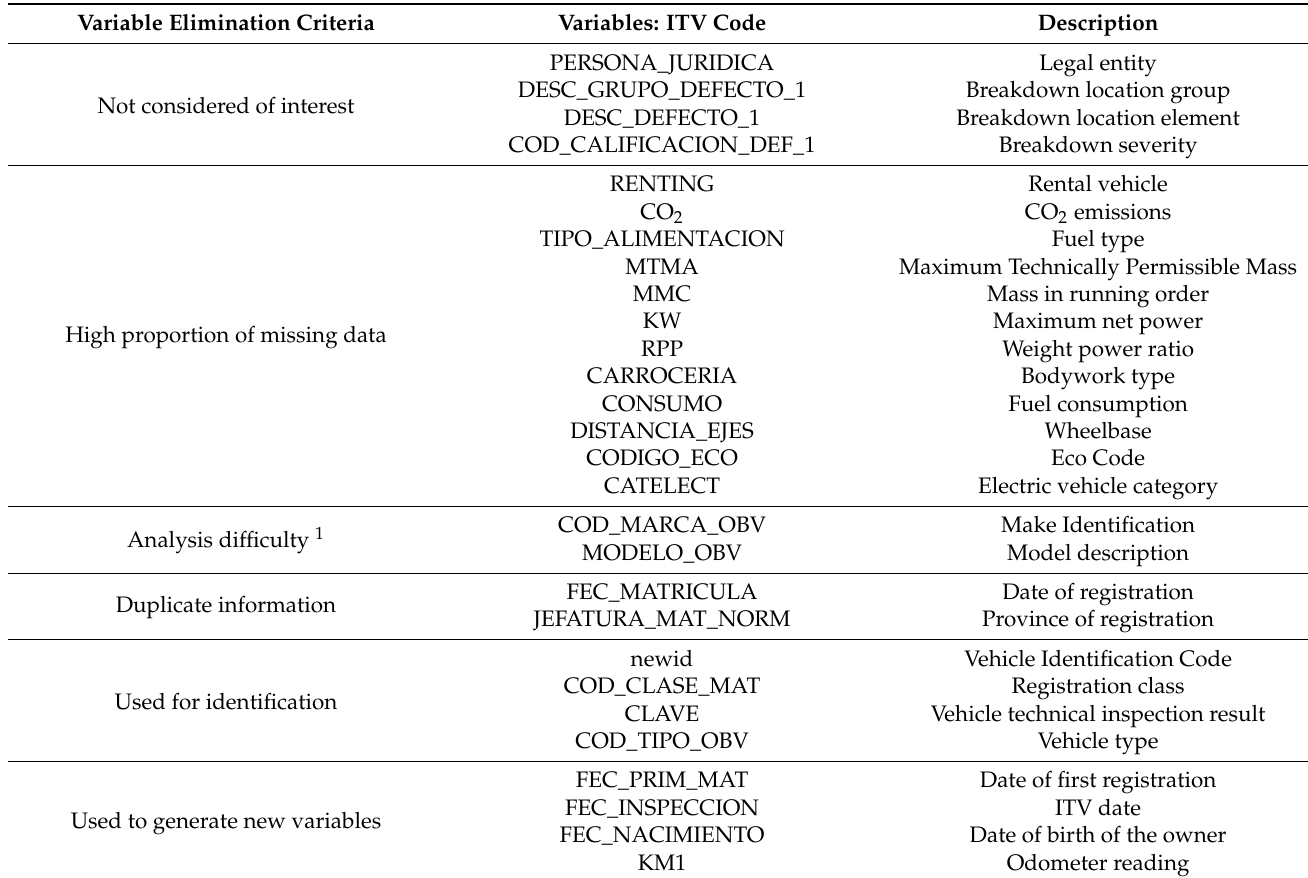
Table 2. Variables